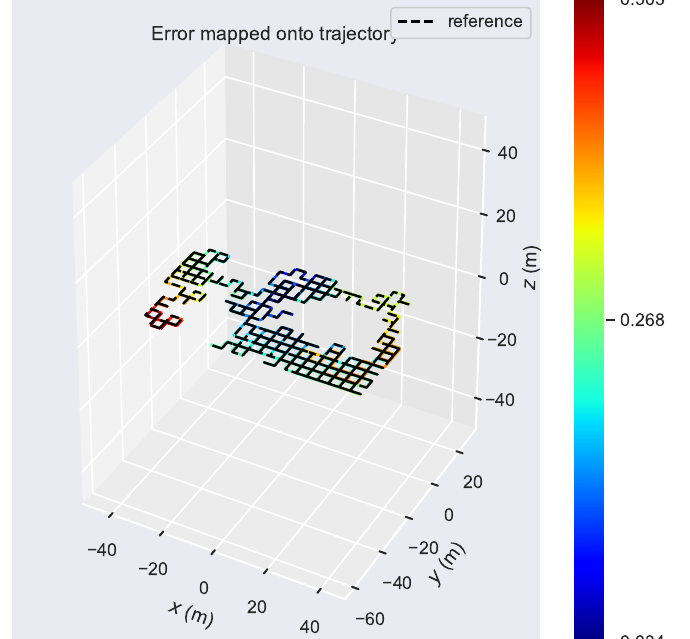
Figure 7. Results of ATE between the ground truth of the manhattan dataset and the map estimated by our method. The color changes from blue to red, and the error gradually